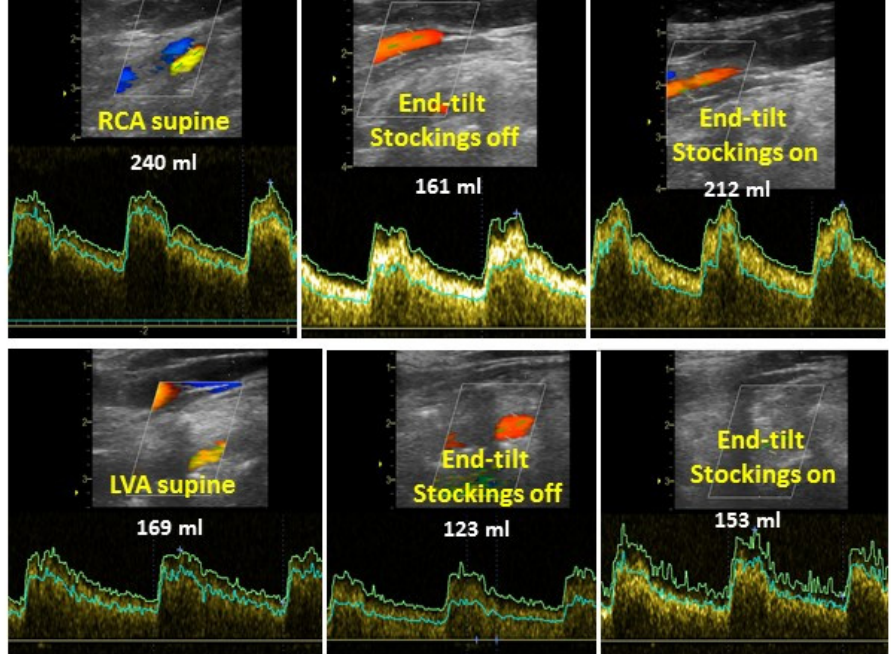
Figure 5. Example of cerebral blood flow supine ( left panel ), at end-tilt without stockings ( middle panel ) and at end-tilt with stockings on ( right panel ). Upper row represents right carotid artery and lower row represents left vertebral